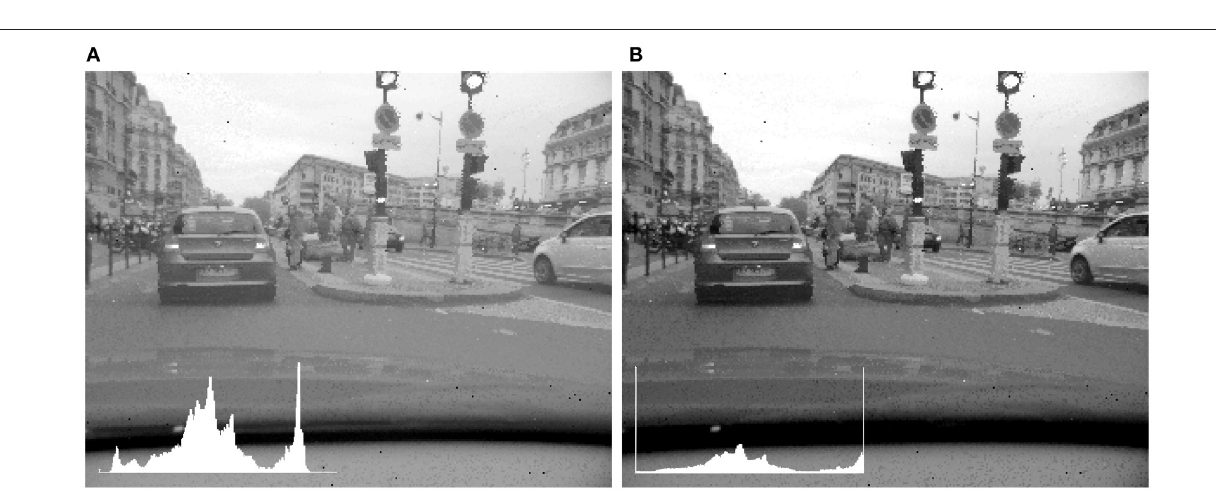
0 and 255. Both images are dark and few details are